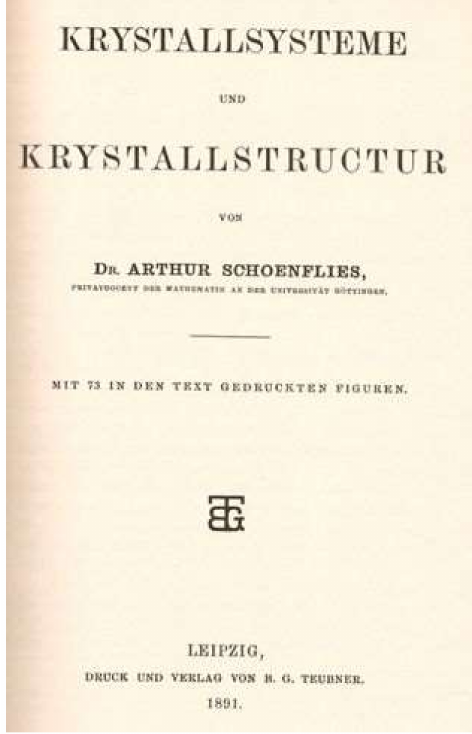
Figure 4. Title page of A. Schoenflies’ book “ Crystal Systems and Crystal Structure ”, published by B.G. Teubner, Leipzig 1891